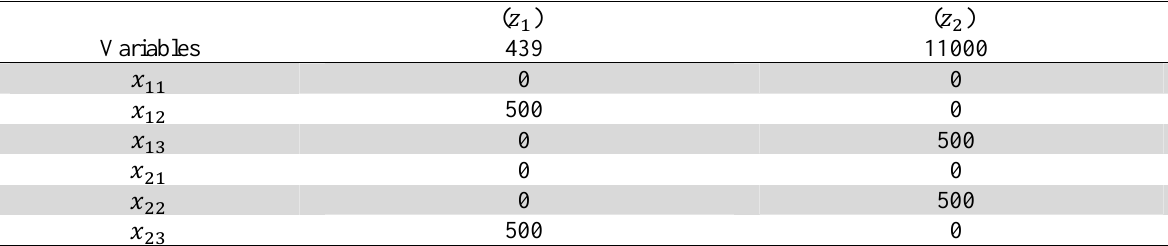
The results of optimal solutions